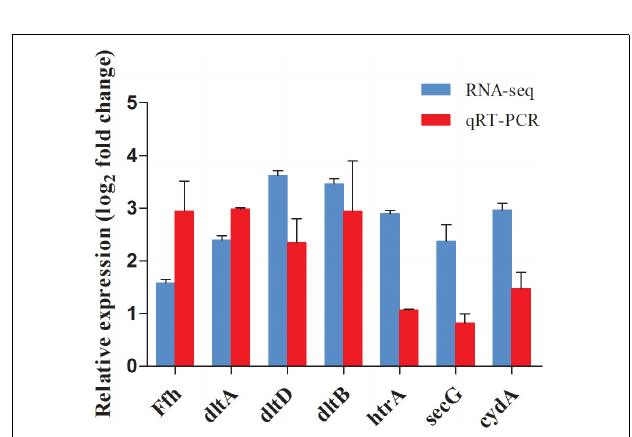
FIGURE 9 | Comparison of gene expression values between RNA-Seq and qRT-PCR analysis. Bars represented the mean values (Mean ± SD; n = 3). Gene expression levels were normalized using the housekeeping gene rpoB as a